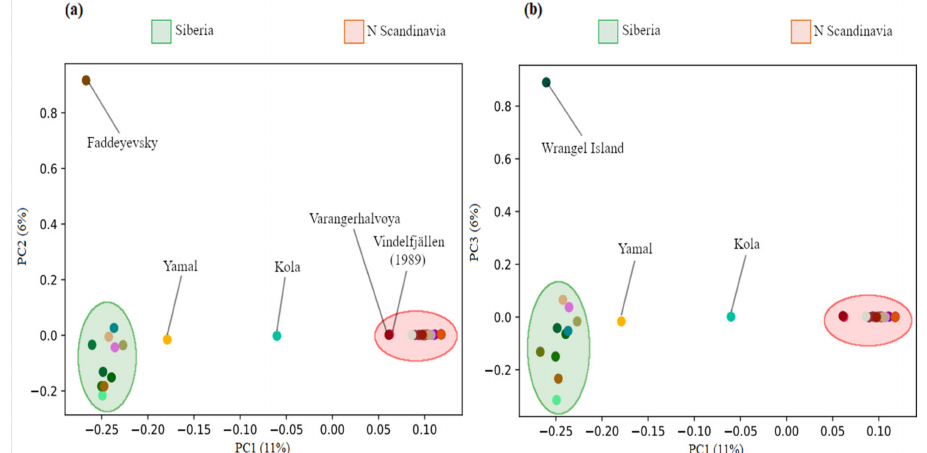
Figure 3. Principal component (PC) analysis of population stratification across samples of arctic foxes on axes ( a ) PC1-PC2 and ( b ) PC1-PC3. Points represent genotypic data for 4,862,746 single nucleotide polymorphisms (SNPs) per individual. The first two principal components (PCs) explained 11% (PC1) and 6% (PC2) of the genotypic variation across all individuals and SNPs. A clear isolation-by-distance pattern is exhibited. PC3 explained 6% of the genotypic